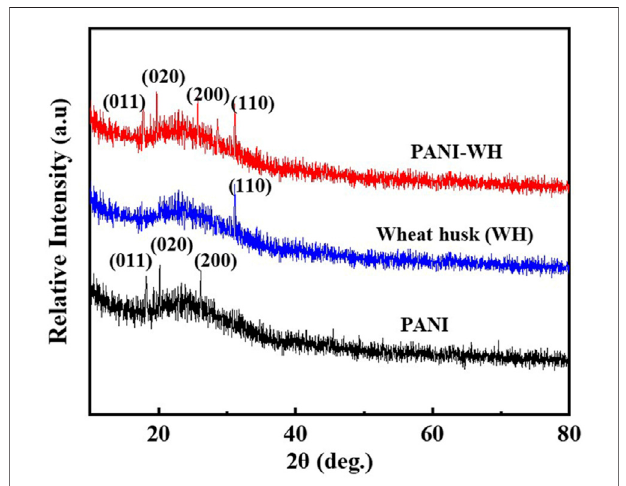
FIGURE 2 | Comparison of XRD spectra of polyaniline (PANI), wheat husk (WH), and PANI-WH.